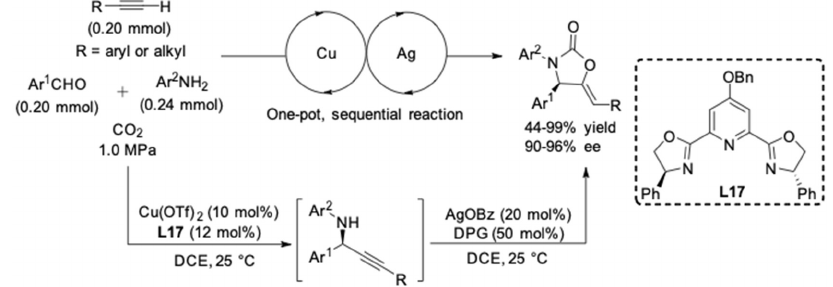
Figure 10. Cu(II)/ s -Bu-pybox-diPh-catalyzed AA 3 -couplings.